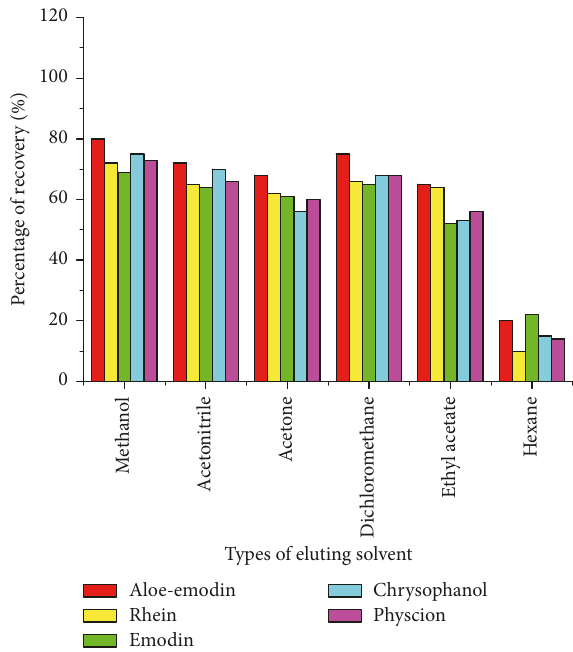
Figure 6: Effect of eluting solvent on recovery of